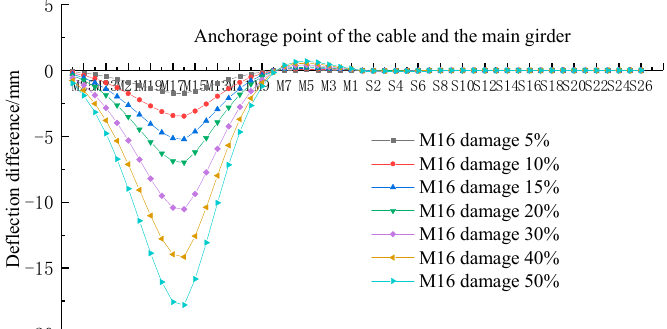
Figure 7. The distribution curves of the deflection difference of the girder before and after different degrees of damage of the stay cable M16.